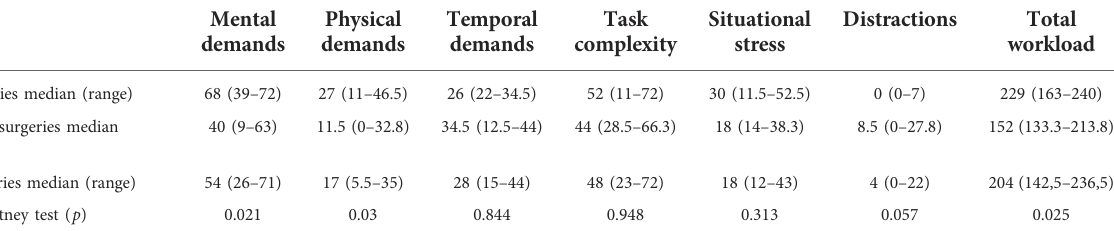
TABLE 3 Comparison of the SURG-TLX forms between both groups of